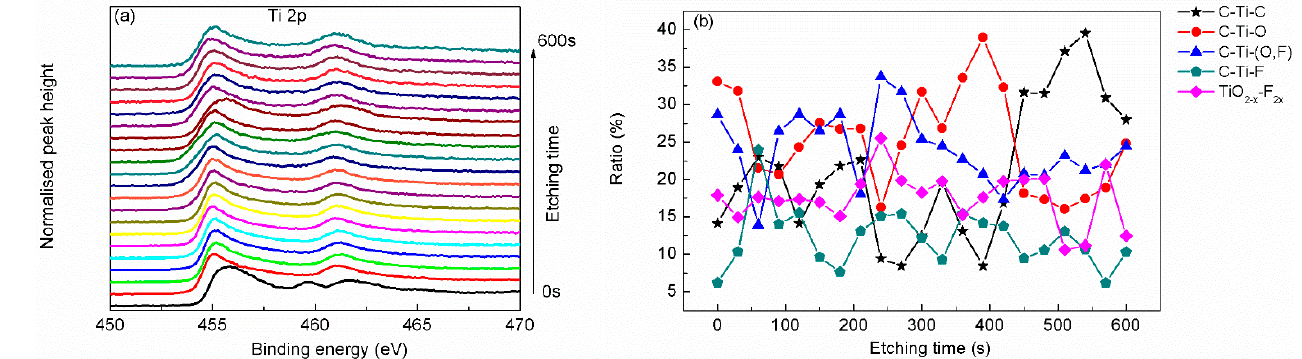
Figure 5. Narrow scanning depth profile ( a ) and state ratio depth profile ( b ) of Ti 2p.